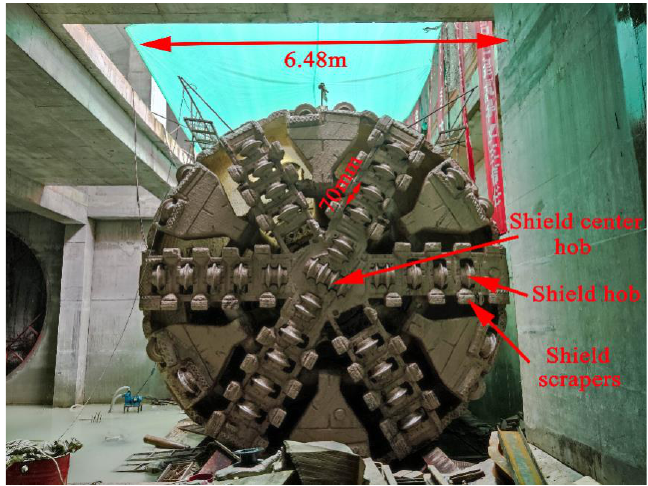
Figure 4. Front view of the EPB